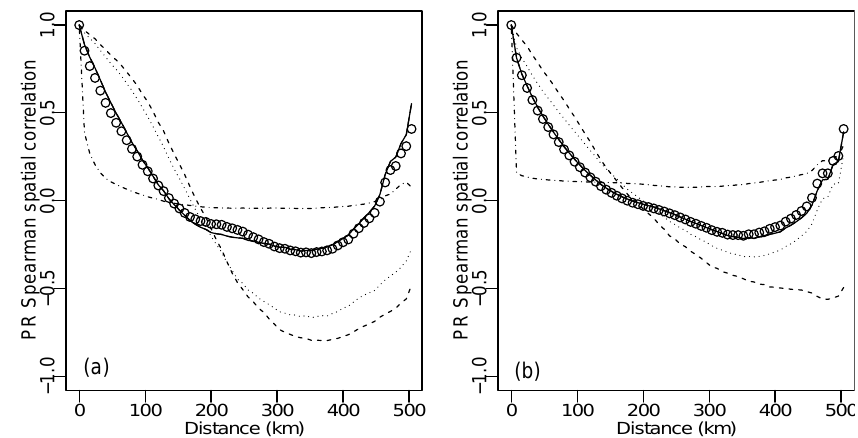
Figure 5. Correlograms in winter over the evaluation period for (a) temperature at 2m; (b) precipitation, from SAFRAN (circles); ERA-I (dashed); 1d-BC (dotted); 2d-BC (dashed-dotted); 1506d-BC (T2 or PR, long dashed); 3012d-BC (solid line). Note that results of the 1506d- (long dashed) and 3012d-R 2 D 2 (solid line) versions are the same and are therefore